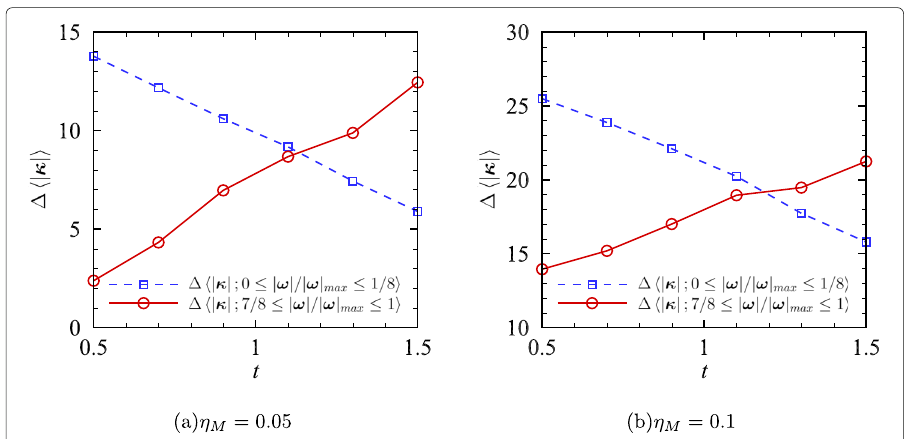
Fig. 13 Temporal evolution of the averaged mean curvature difference in cases M1 and M2 conditioned on low- and high- | ω |